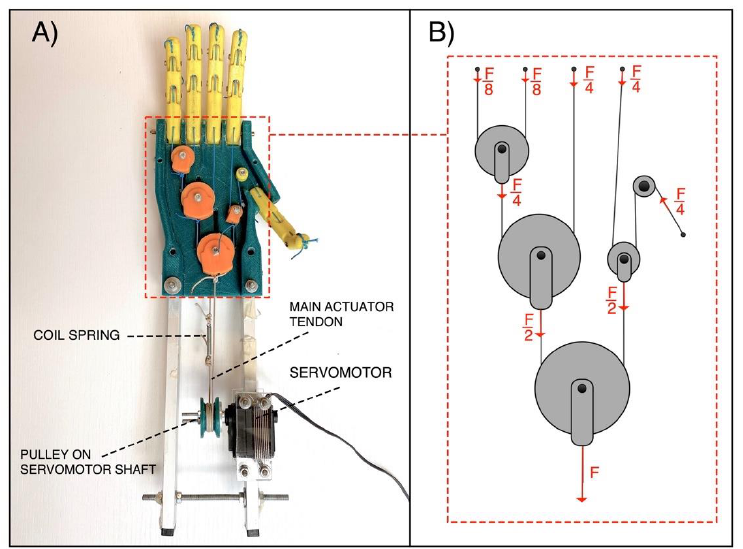
Figure 4. The “Federica” hand: ( A ) Palm side exposed; ( B ) Force distribution in the differential mechanical system, made of pulleys and inelastic tendons.